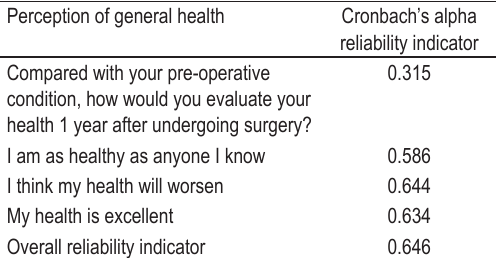
TABLE 1. Perception of the general health status of the respondents 1 year after undergoing the